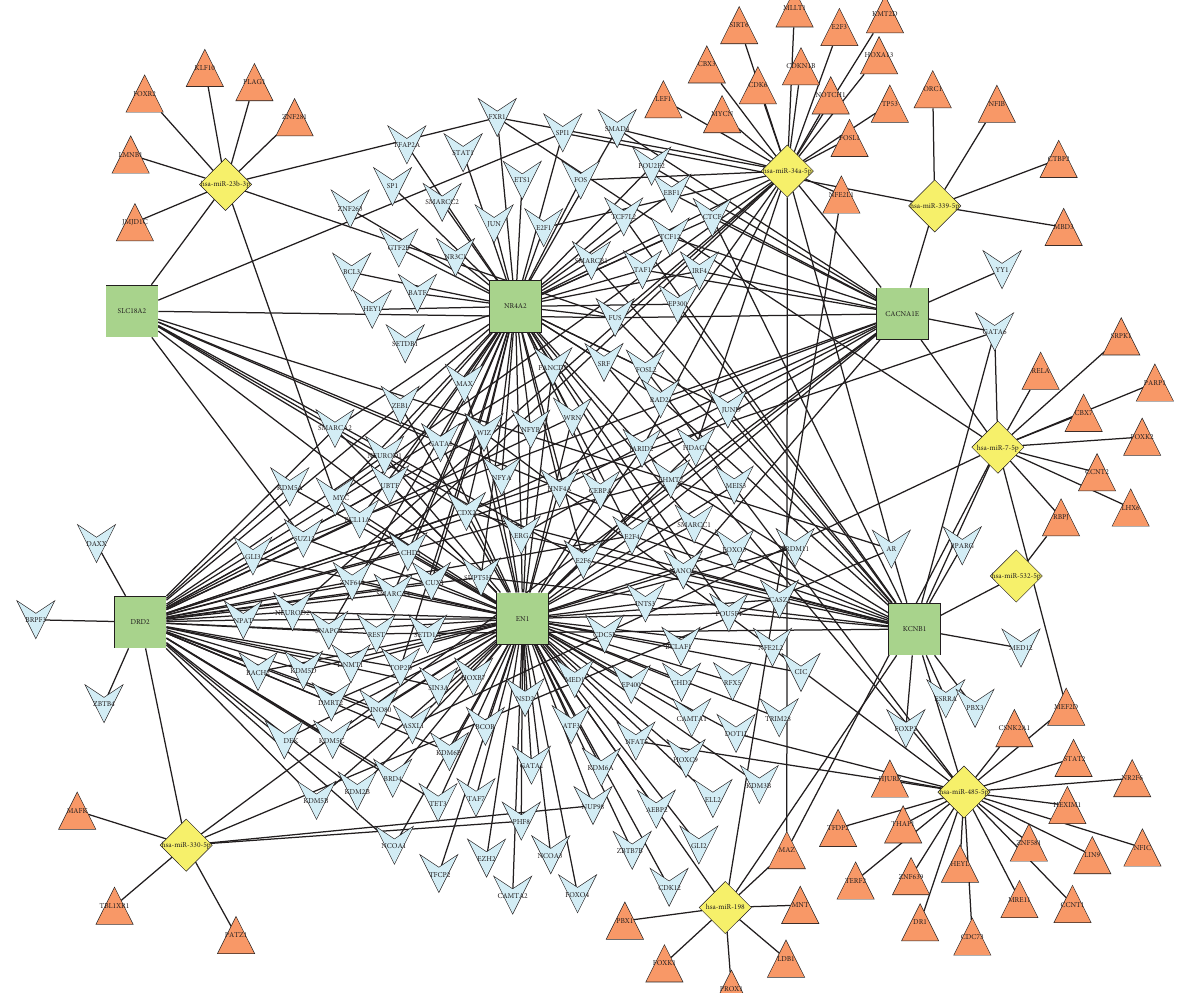
Figure 7: Te mTF-miRNA-gene-gTF regulatory network. Te square-shaped green nodes represent hub genes, the diamond-shaped yellow nodes represent miRNAs, the V-shaped blue nodes represent the TFs associated with hub genes (gTFs), and the triangle-shaped orange nodes represent the TFs associated with miRNAs